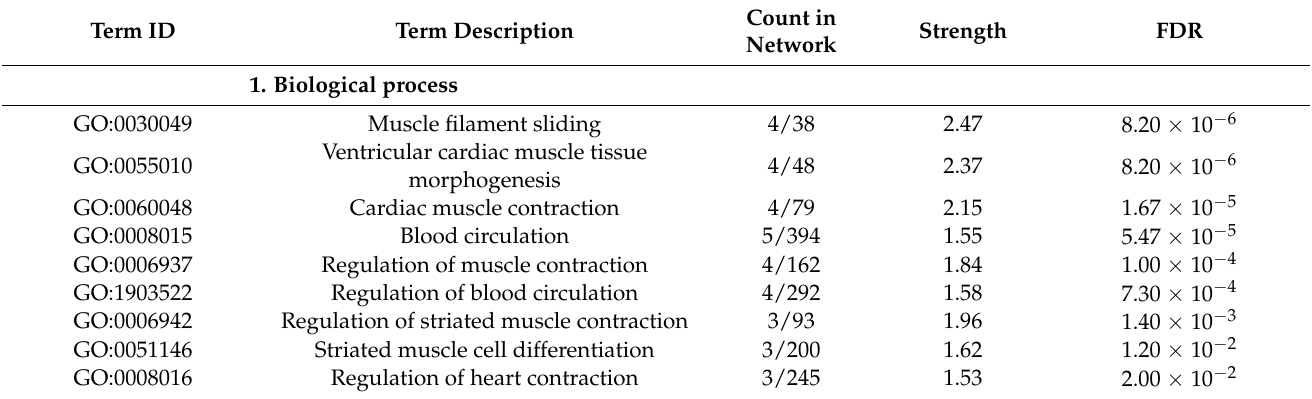
Table 5. Gene Ontology and KEGG pathway analyses of novel loci-related genes associated with